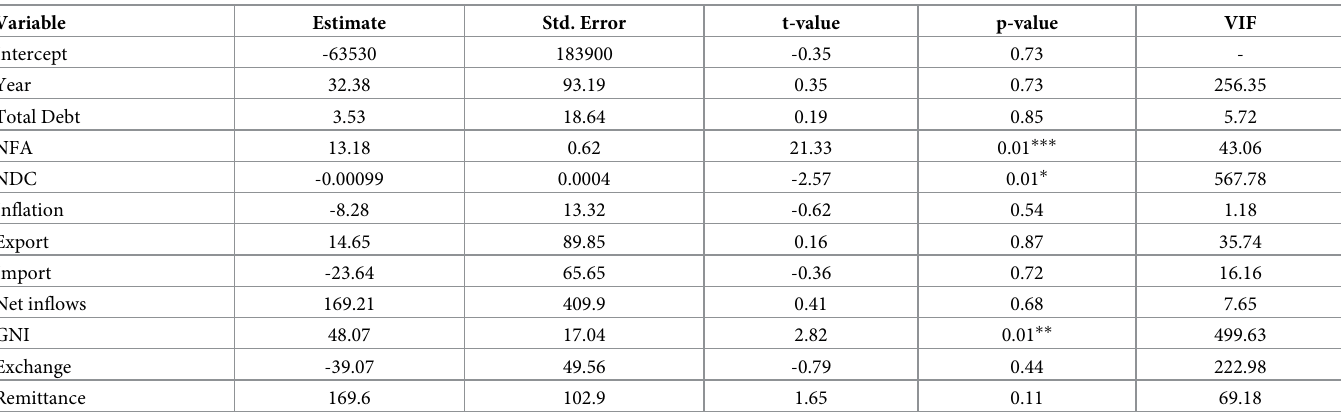
Table 2. Estimates of the multiple linear model.